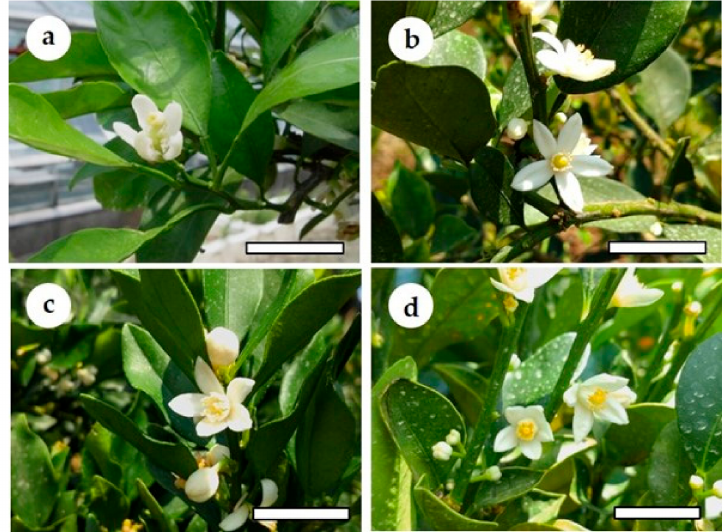
Figure 8. Comparison of morphological characteristics of flowers and flowering habits in ‘Kiyomi’ tangor, Meiwa kumquat, and their hybrids. ( a ) ‘Kiyomi’ tangor, ( b ) H15-701, ( c ) H15-702, ( d ) Meiwa kumquat. Bars = 2.0